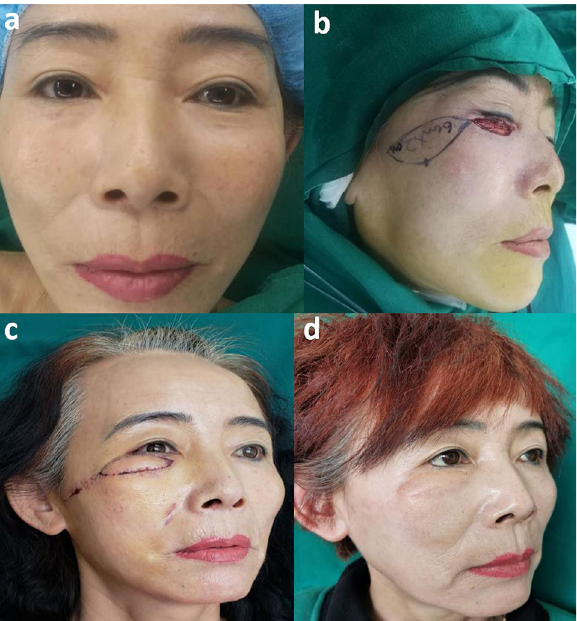
Figure 2. ( a , b ) A 52 years old female diagnosed with basal cell carcinoma. The tumor was resected and she was performed this subcutaneous pedicled propeller flap for reconstructing the large eyelid defect. ( c ) When the sutures were removed 7 days after the operation, the flaps survived well. ( d ) After 1 year of follow-up, the scar was not obvious, the appearance was satisfactory, there was no tumor recurrence, and no traction deformity.